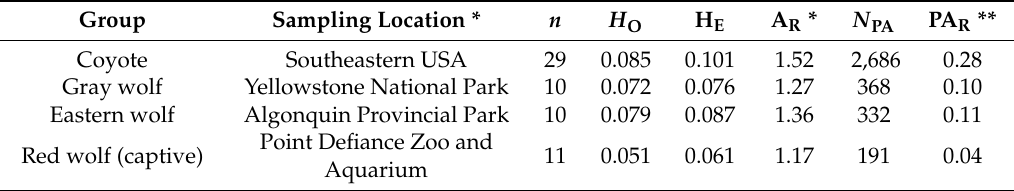
Table 1. Diversity statistics for each reference group of Canis in North America. Summary statistics for each Canis reference population derived from 7047 genome-wide polymorphic SNPs.